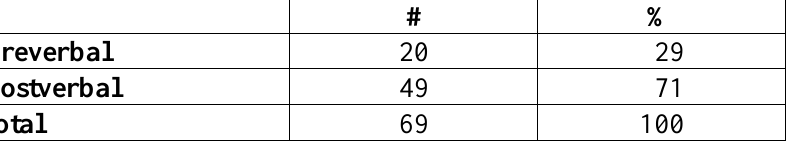
Table (9): Positioning of the overt subject in direct non-cleft argumental wh